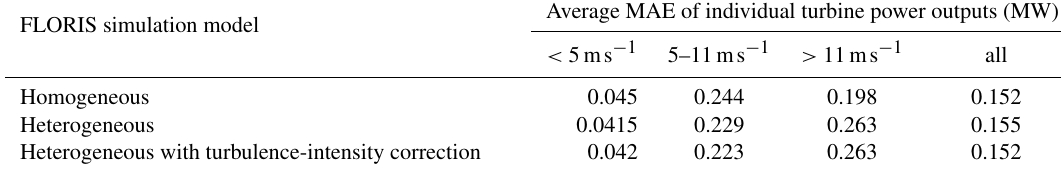
Table B4. Analysis of wake influence in the observed wind farm discussed in Sect. 4.2. This table shows the average mean absolute error of individual turbine power output for three different FLORIS models, omitting FLORIS wake loss calculations. This average was taken over all time steps, and the total rated wind farm output was scaled to 100MW for